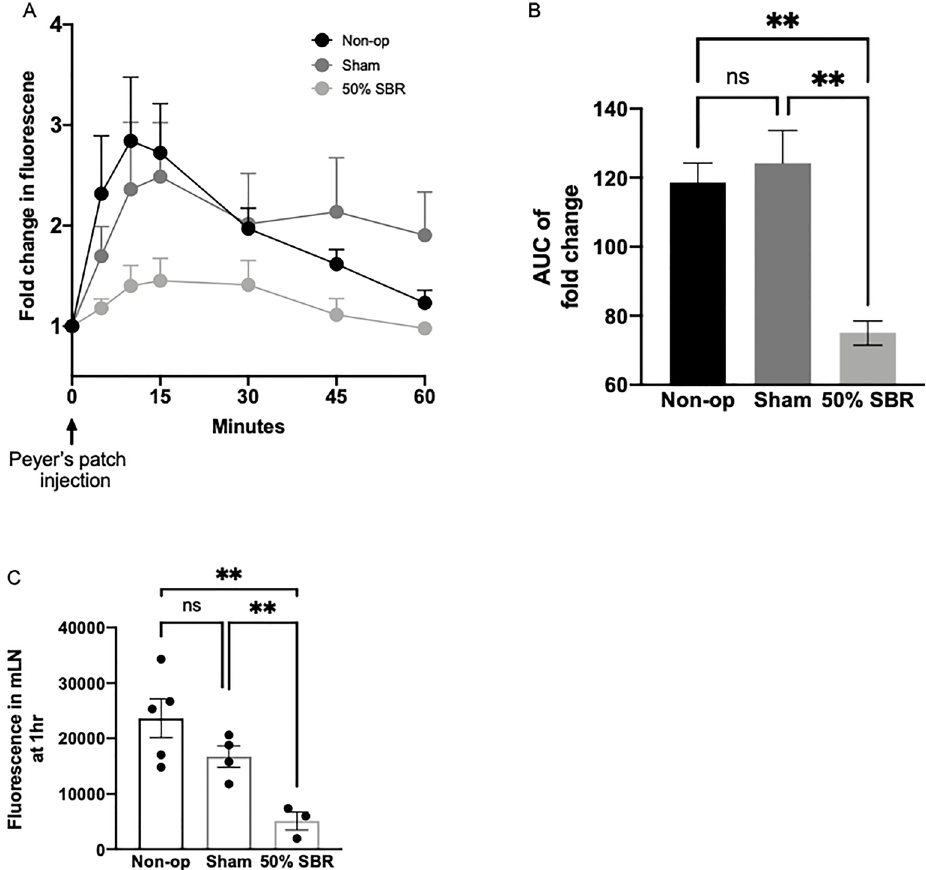
Figure 7. ( A ) Kinetic measurement of lymphatic flow from Peyer’s patch injection to systemic blood by fluorescence, presented in fold change from pre-injection baseline, in non-op ( n = 8), sham ( n = 6), and 50% SBR ( n = 4) mice, with resultant ( B ) area under the curve. (C) Measurement of fluorescence in the mesenteric lymph node (mLN) at one hour in non-op ( n = 3), sham ( n = 4), and 50% SBR ( n = 3) mice after Peyer’s patch injection. ** p <